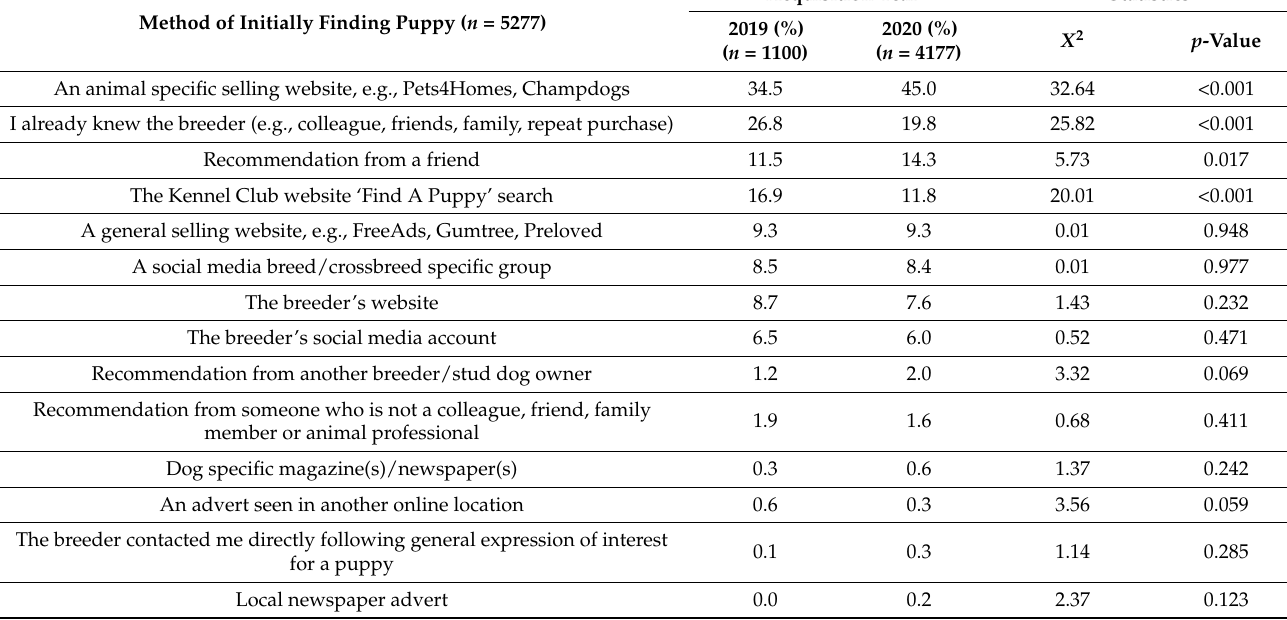
Table 7. Places owners found their puppy with comparisons between 2019 puppy ( n = 1100) and Pandemic Puppy owners ( n = 4177) in the